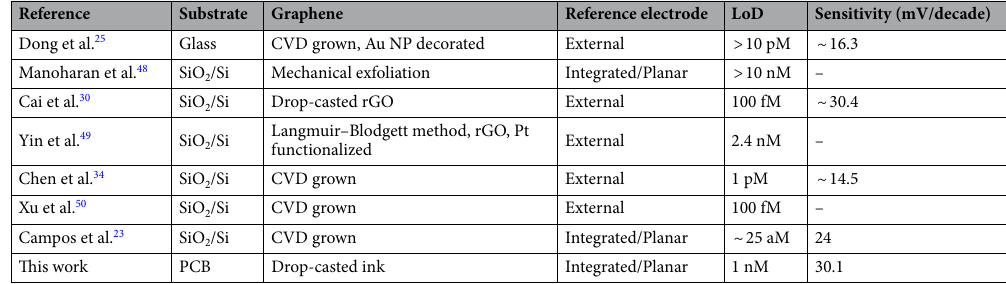
Table 1. Literature survey of graphene-based electrolyte-gated FET DNA biosensor